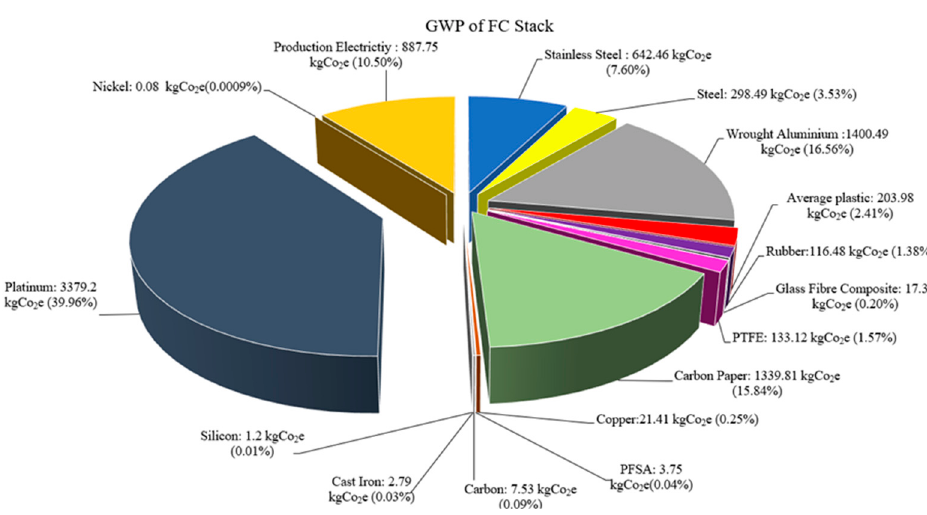
Figure 3. Comparison of GWP per System.